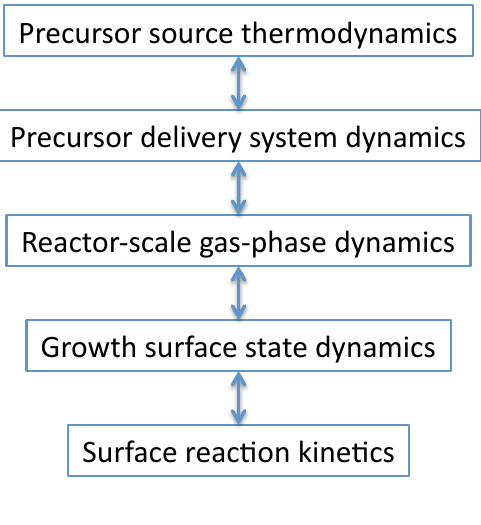
Figure 2. Elements of a complete ALD reactor system mathematical